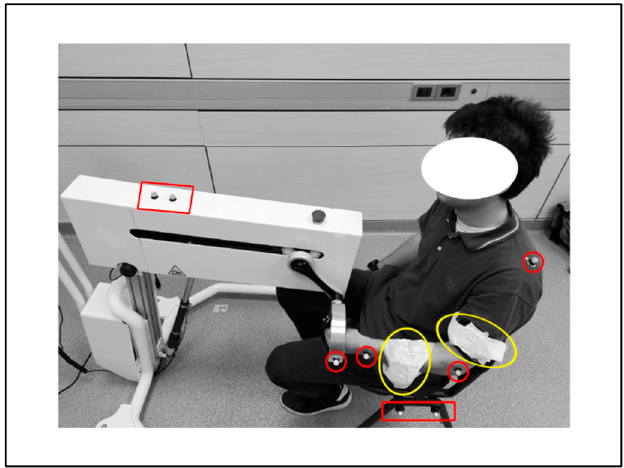
Figure 2. Positioning of accelerometers, indicated with the yellow frames, and of the markers, identified by the red frames. Circles are used for the markers of the moving elements, and square frames for the markers adopted for the environment analysis.